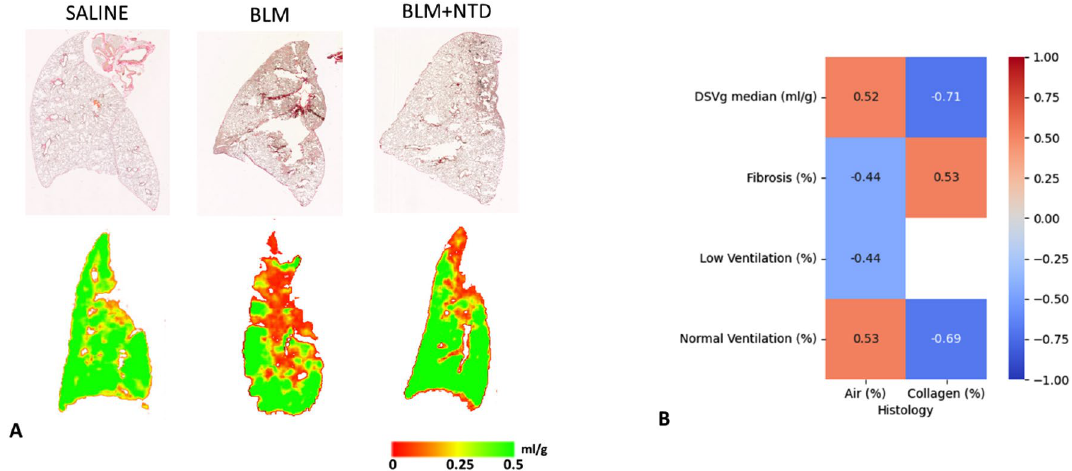
Figure 8. On the left, histological sections were reported with the corresponding ventilation maps, at day 21, showing that regions with moderate and severe lesions are characterized by low/no ventilation. Colour scale of ventilation images indicates the SVg difference between the inspiratory and the expiratory images (ml of air per gram of tissue). On the right, Spearman matrix calculated between ventilation parameters and histological measures. The colour bar evidenced high positive correlations in red and high negative trends in blue. The correlation coefficient (r) is reported in each box, when